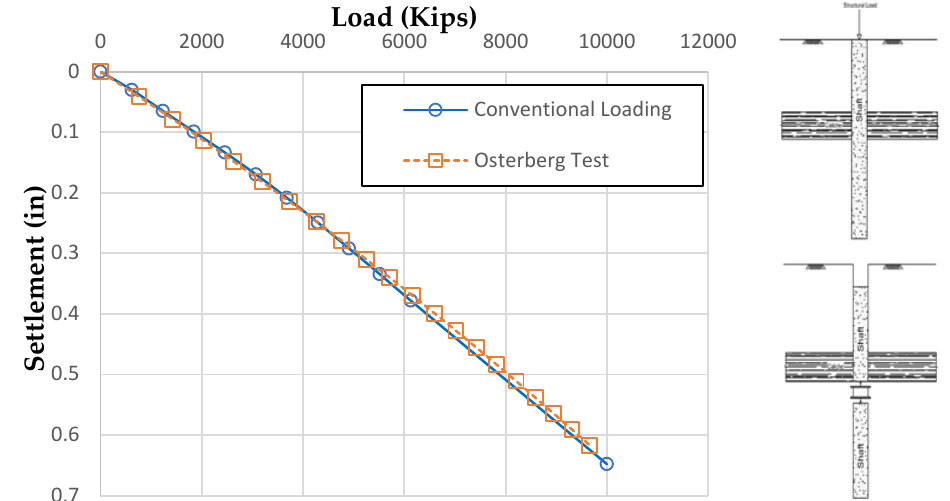
Figure 13. Constructed top-down curves based on the proposed back analysis, along with the conventional method according to the Osterberg assumptions, Case Study II.